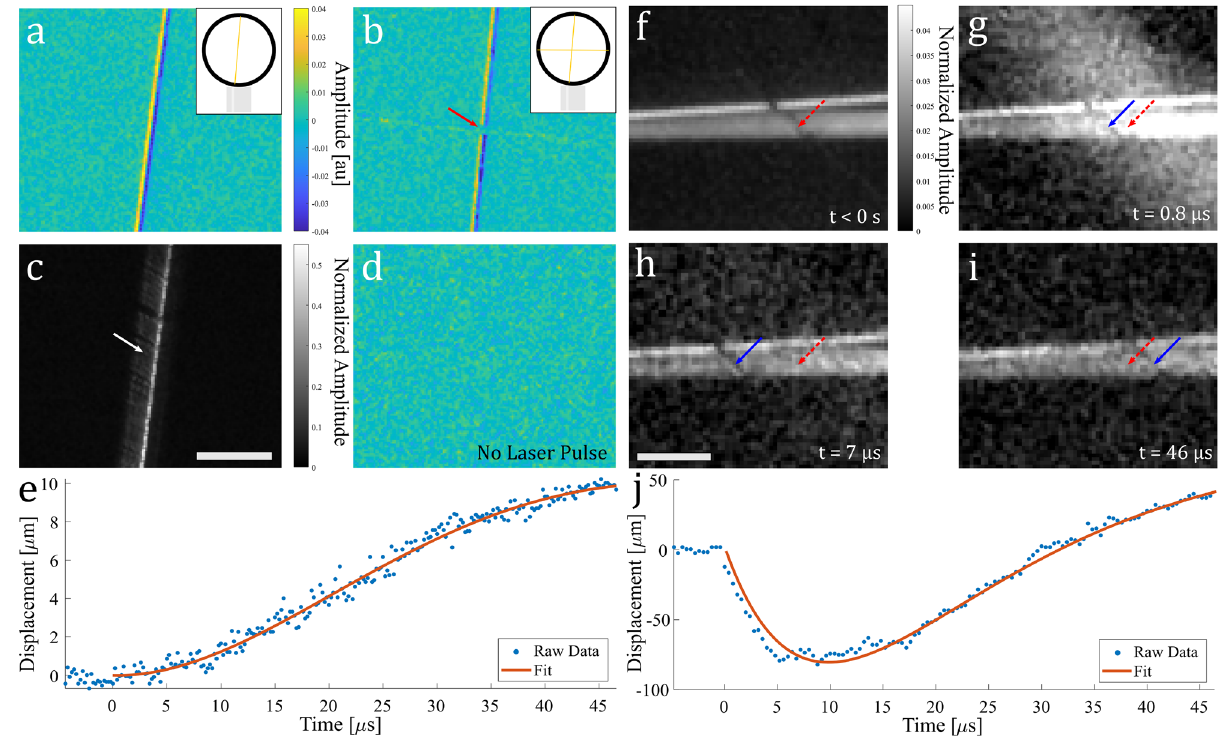
Figure 3. ( a ) Single and ( b ) crossed 25 µ m diameter gold wire in air and in tension last frame and mean of pre-excitation frames difference image; ( c ) excitation frame for ( a ); ( d ) first and last frame difference image with no excitation pulse; scale bar: 200 µ m. ( e ) Wire displacement plot against time for the motion shown in ( a ). ( f ) pre-excitation frame of a 7 µ m diameter carbon fiber target diagonally suspended in air and in tension in front of a pair of 50 µ m diameter aluminum and 25 µ m diameter gold wires, with the red dashed arrow indicating pre-excitation fiber location; ( g )–( i ) fiber location displacement over time with the solid blue arrow indicating the current frame fiber location; scale bar: 100 µ m. ( j ) Fiber displacement plot against time for the motion shown in ( g )–( i